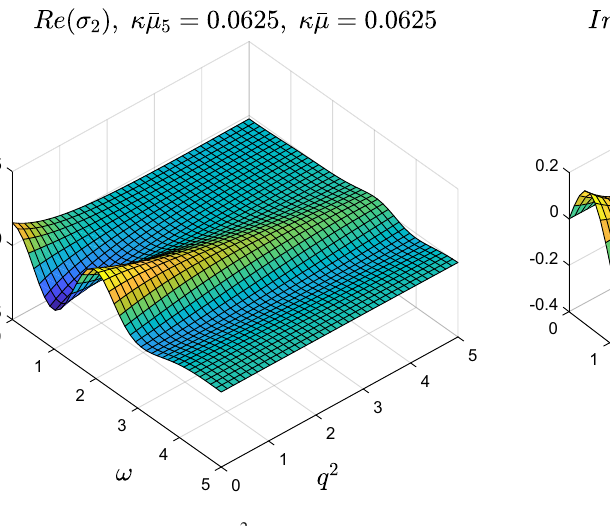
Fig. 15 TCF σ 2 as a function of ω and q 2 when κ ¯ μ = κ ¯ μ 5 = 1 / 16